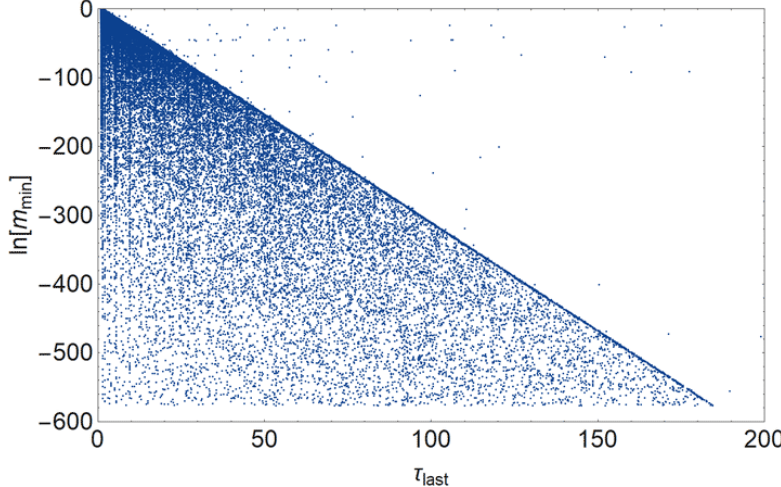
Figure 12. ln( m min ) evaluated at t \